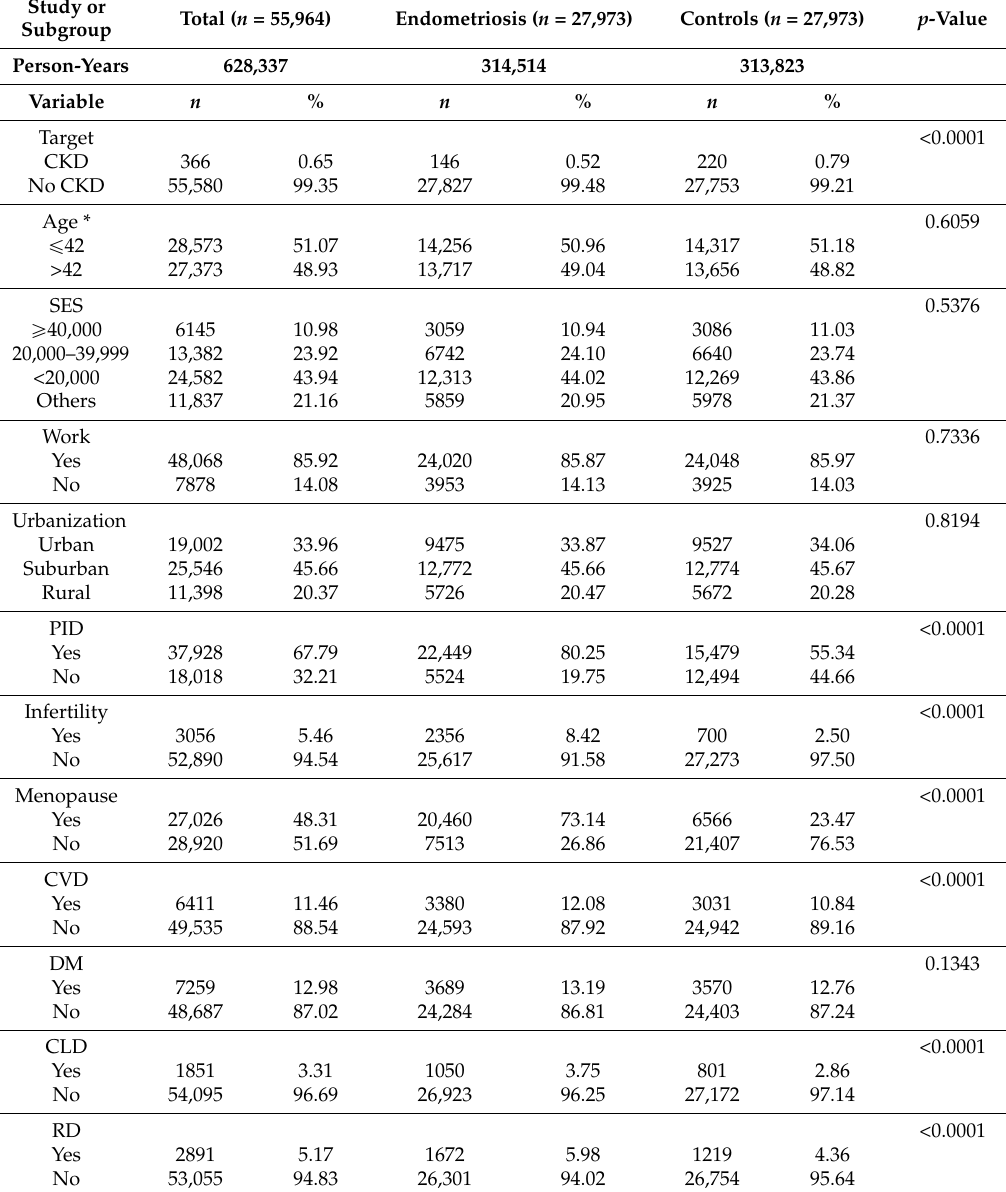
Table 1. Baseline characteristics of the study